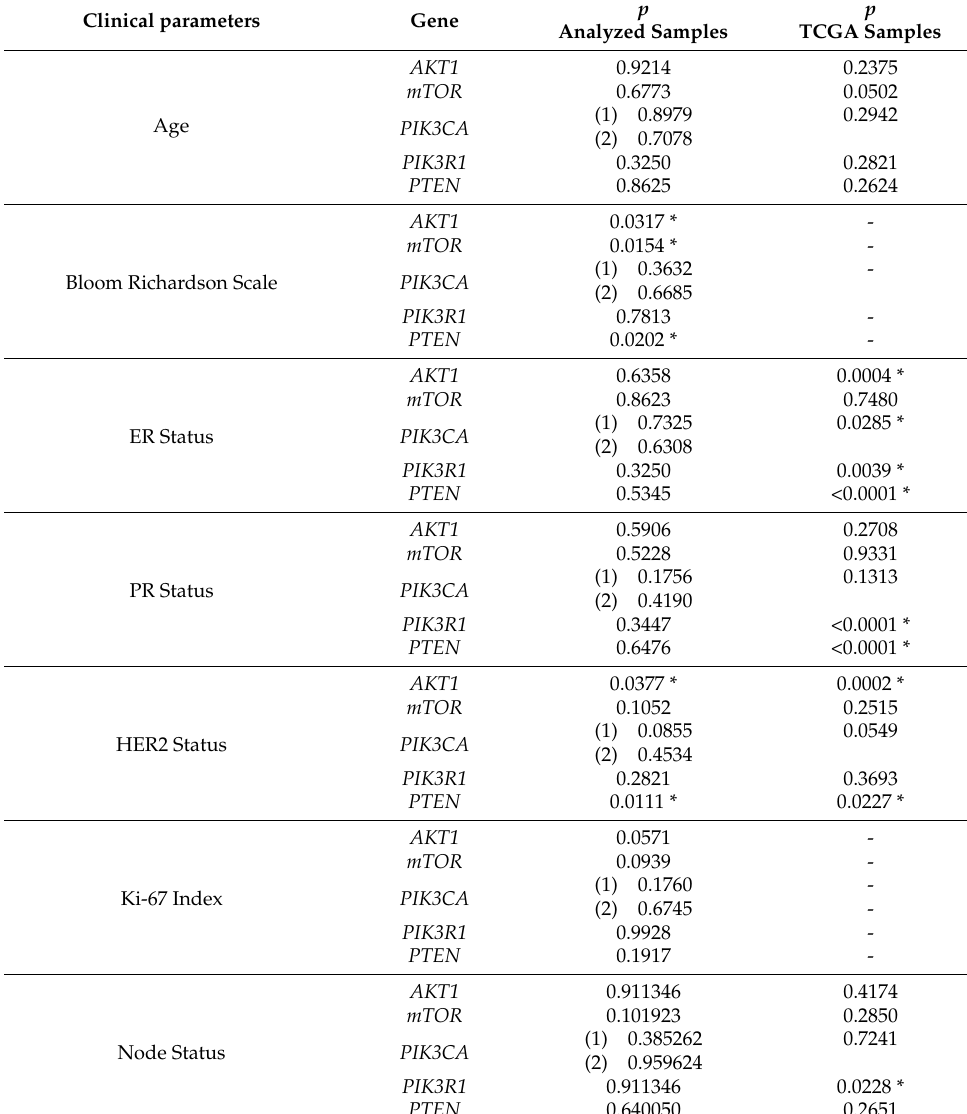
Table 4. The expression level of the studied genes in depending on clinical parameters in analyzed samples and TCGA samples (web source the